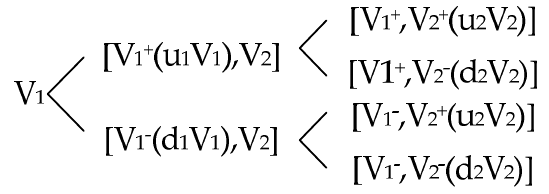
Figure 5. Changes in the increased value at two stages.